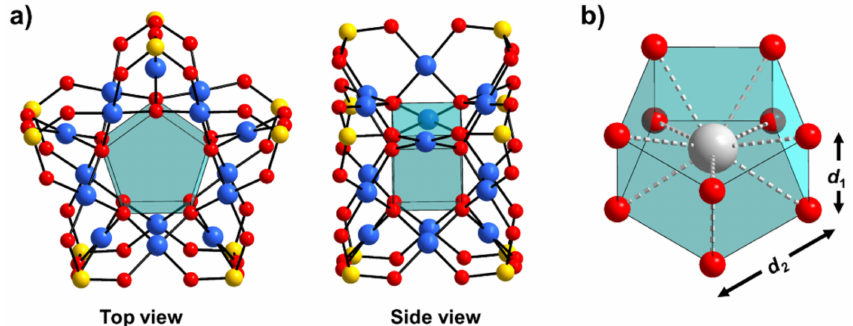
Figure 1. Combined polyhedral and ball-and-stick representation polyanion 1 ( a ) with detail of the inner cavity suitable for encapsulation of metal cations ( b ). The assigned d 1 and d 2 refer to interatomic O ··· O distances that define the size of the inner cavity (vide infra). Color code: Se = yellow, Pd = blue, O = red, and Na/Ln = grey spheres. {O 10 }/{MO 10 } = cyan transparent